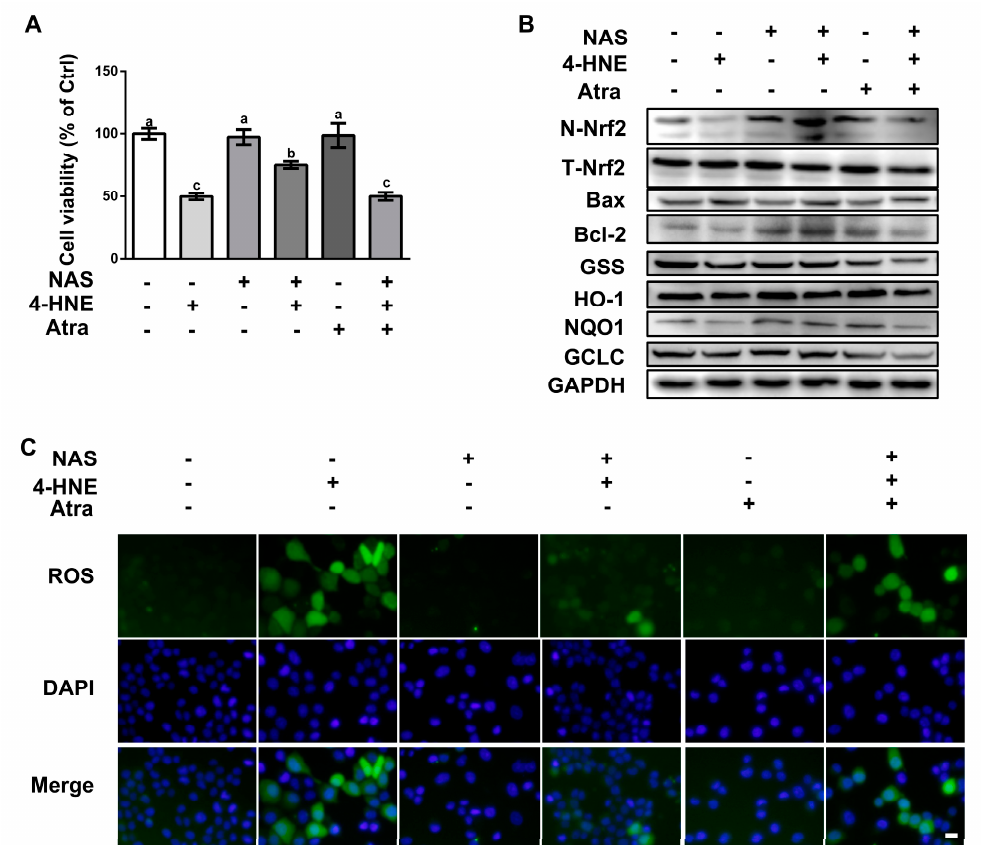
Figure 5. NAS protected cells against 4-HNE-induced apoptosis in a Nrf2-dependent manner. Cells pretreated with or without NAS (100 μ M, 12 h) were exposed to 4-HNE (20 μ M) for 2 h in the presence or absence of Atra (2 μ M). Cell viability ( A ), the protein abundances for N-Nrf2, T-Nrf2, Bax, Bcl-2, GSS, HO-1, NQO1, and GCLC ( B ), and intracellular ROS levels ( C ) were assessed. Representative results from three independent experiments were provided, and values are means ± SEMs, n = 3. Means without a common letter differ, P < 0.05.